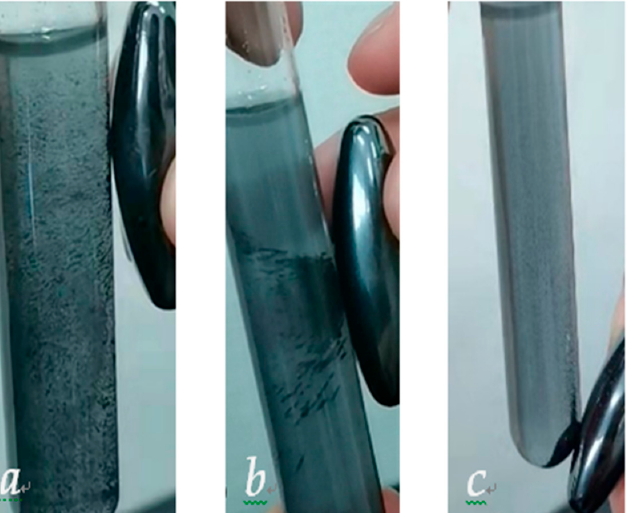
Figure 2. HTPB/nNi dispersed in anhydrous ethanol (( a ) Before attraction; ( b ) During attraction; ( c ) After attraction).